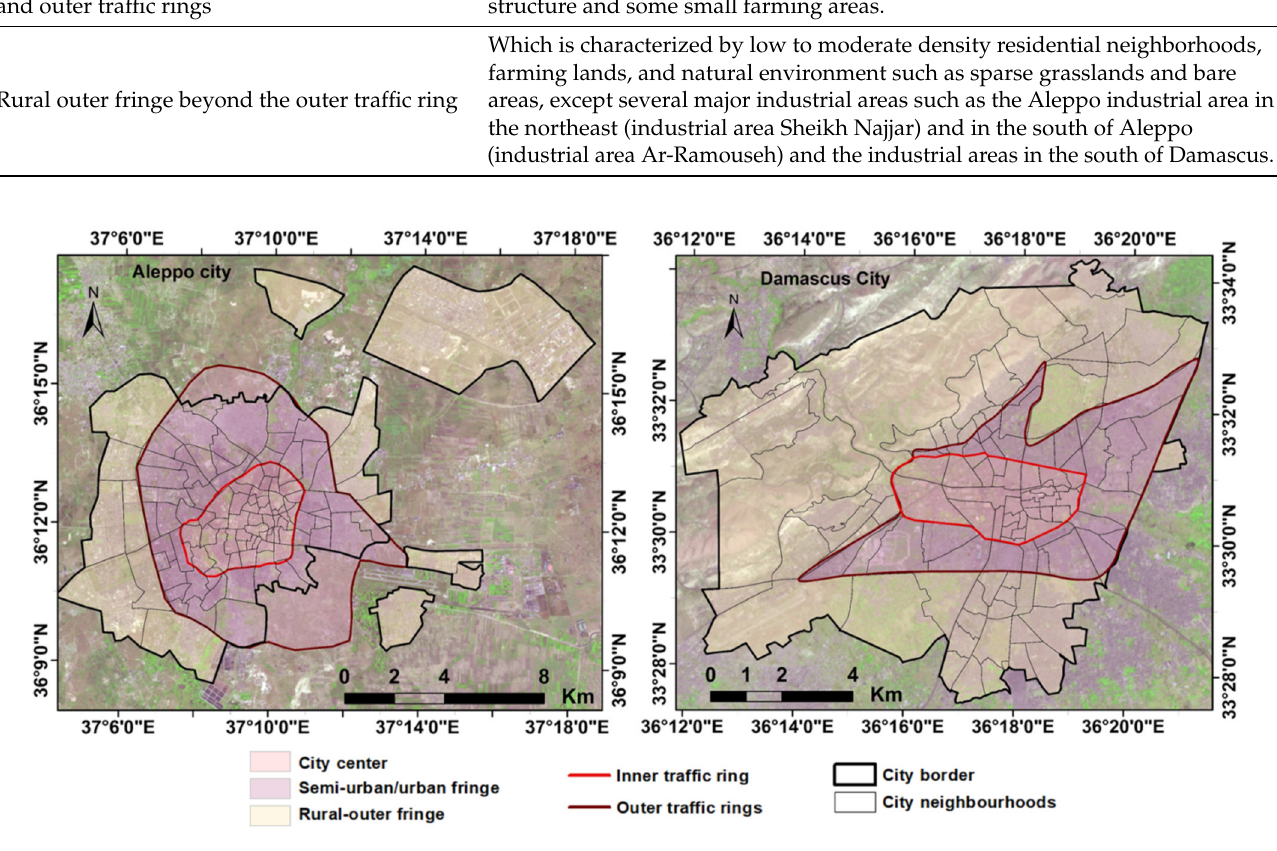
Figure 2. Divisions of the study areas in three levels in accordance with the classification of land use patterns and the traffic rings. The background is Landsat 8 OLI images of 2018 (band 6-5-4 as